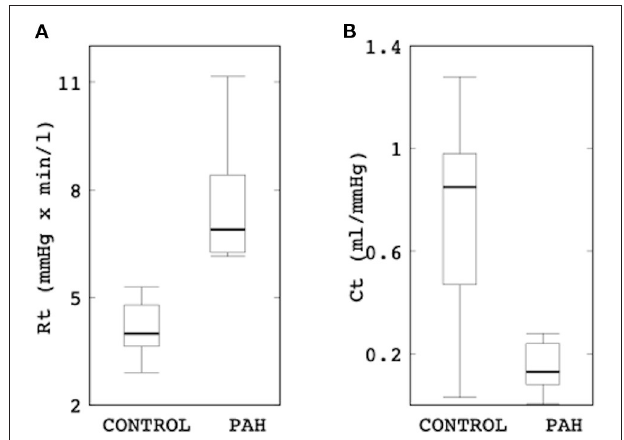
0.84, = FIGURE 6 | Comparison of (A) the total distal resistance (control: median: 3.99 mmHg min/l, IQR: 1.15 mmHg min/l vs. PAH: median: 6.89 mmHg × × min/l, IQR: 2.16 mmHg min/l; P 0.002) and (B) total distal compliance × × = (control: median: 0.85 ml/mmHg, IQR: 0.51 ml/mmHg vs. PAH: median: 0.13 ml/mmHg, IQR: 0.15 ml/mmHg; P 0.041) between the control and PAH =